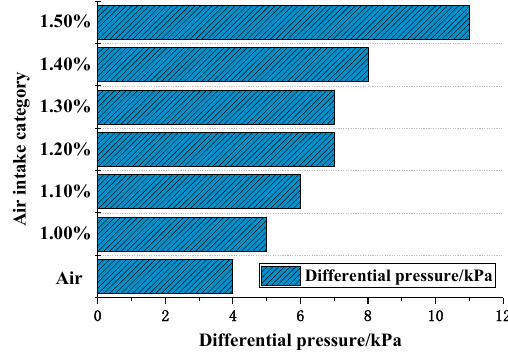
Figure 9. Pressure difference between inlet and outlet.